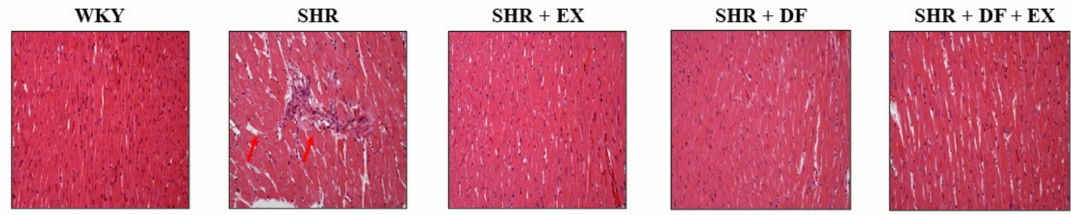
Figure 4. Effects of DF peptide and exercise on cardiac structure in rats. H&E